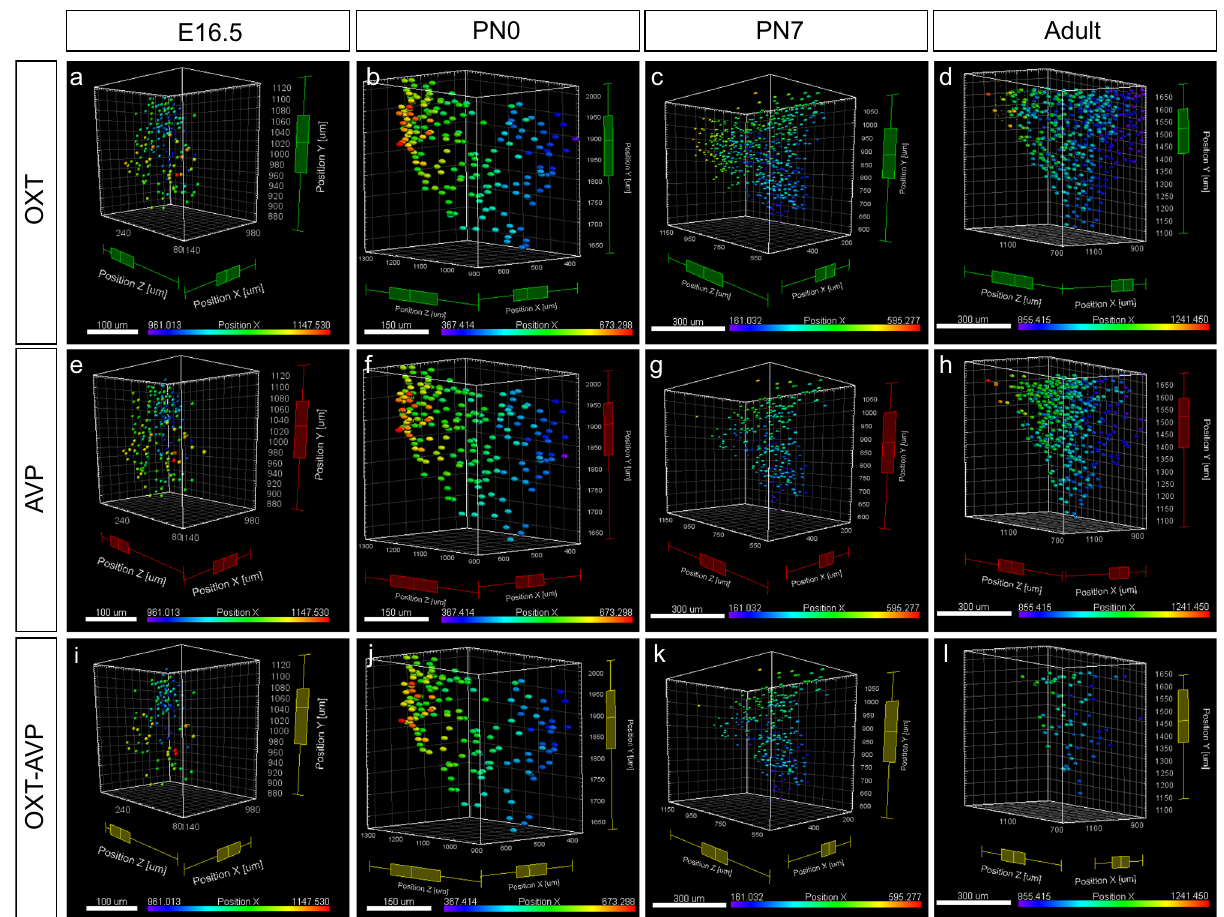
Fig. 7 Spatial cell distribution in the PVN during development. Cell distribution of OXT ( a – d ), AVP ( e – h ) and OXT + AVP ( i – l ) neurons are represented at E16.5, PN0, PN7 and adult brain. Each plot shows the cell distribution, represented as spots in the 3D brain reconstruction. Colors indicate distance to the midline. Each developmental stage is indicated with a histogram of different color. Each plot includes the minimum value, quartile 1 (Q1), median, quartile 3 (Q3) and the maximum value per each axis ( x, y and z ). X position : E16.5 OXT: min = 961.00; Q1 = 1009.00; median = 1046.00; Q3 =